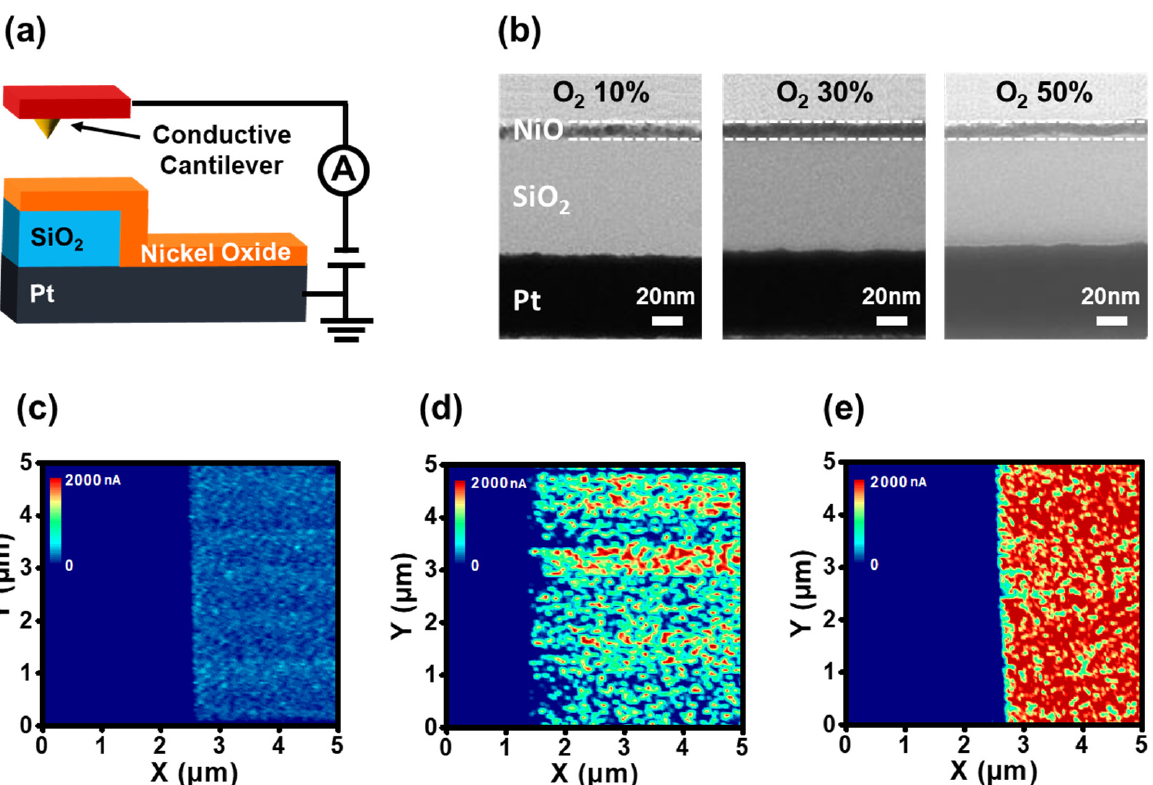
Figure 5. ( a ) Schematic diagram of the C-AFM measurement. ( b ) Cross-sectional TEM image of Ni 1 − x O films deposited at various oxygen partial pressure. C-AFM current mapping images of the pristine Ni 1 − x O films under oxygen partial pressure fraction of ( c ) 10%, ( d ) 30%, and ( e ) 50%.